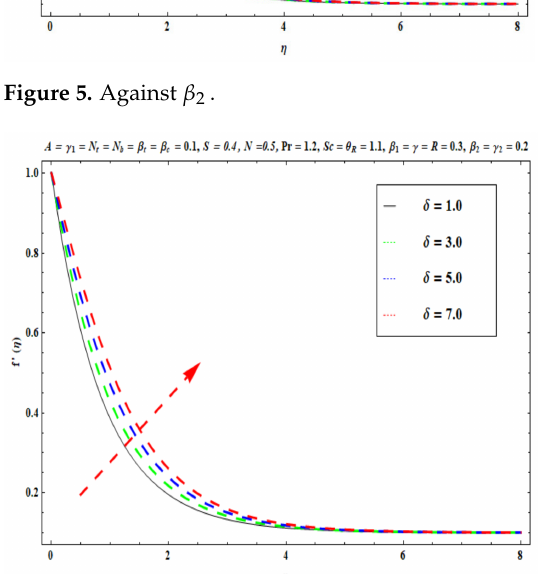
Figure 6. Against δ